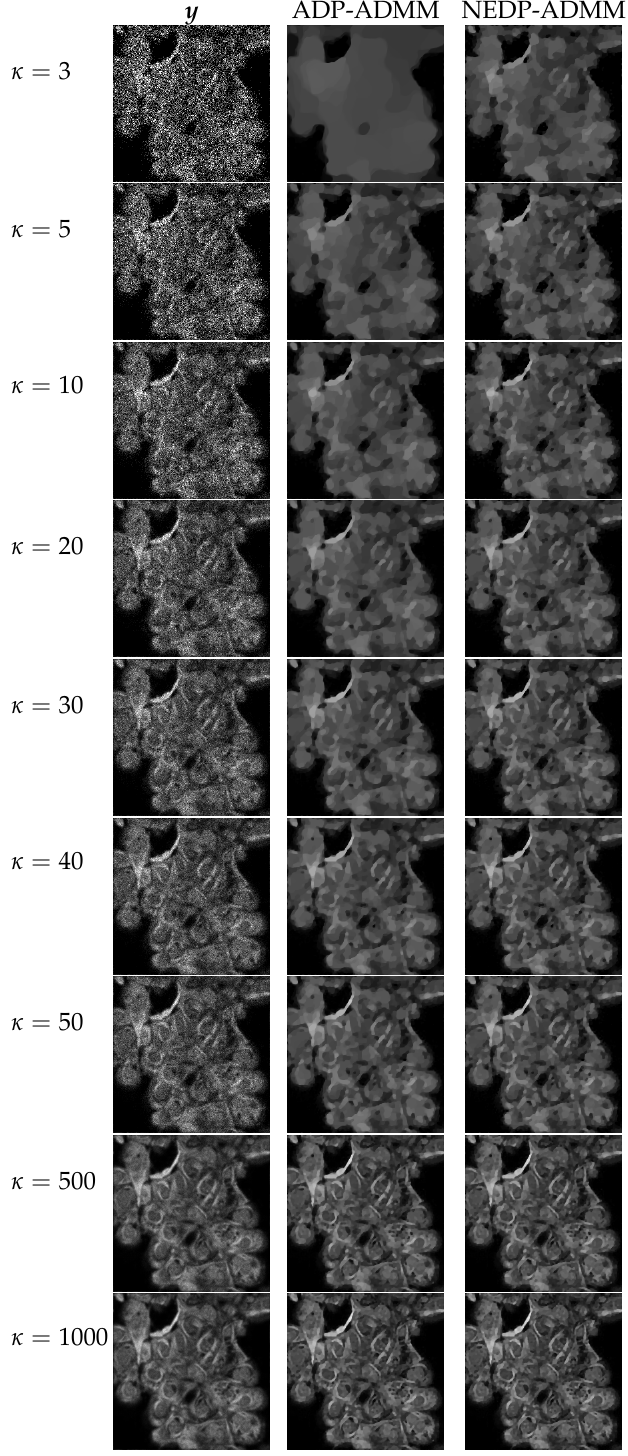
Figure 16. Test image cells . Left column: observed data y corrupted by Gaussian blur with parameters band = 5, sigma = 1 and Poisson noise with different κ -values ranging from 3 to 1000. Middle column: restorations by ADP-ADMM. Right column: restorations by